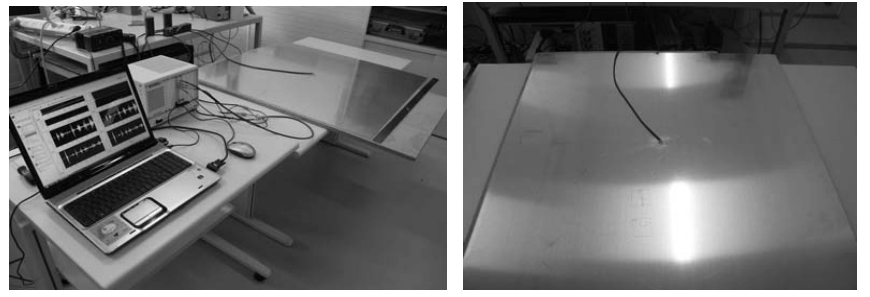
Fig. 10. Experimental